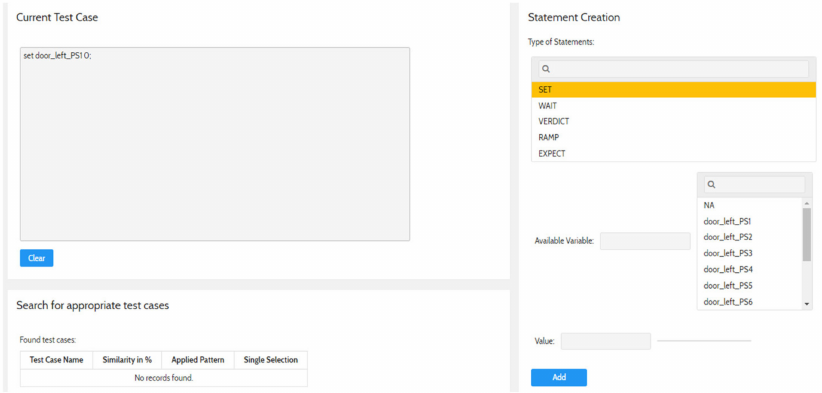
Figure 17. Screenshot of http://testadvisor.eu (accessed on 5 January 2023) how to add a statement to the